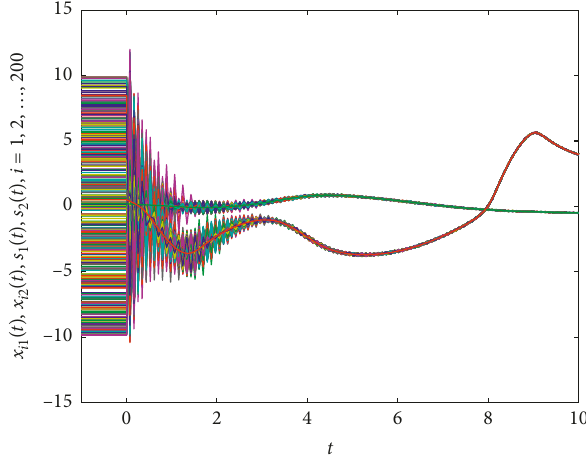
Figure 17: Time evolution of nodes’ states x under sampled-data feedback, i � 1 , 2 , .. . , 200.